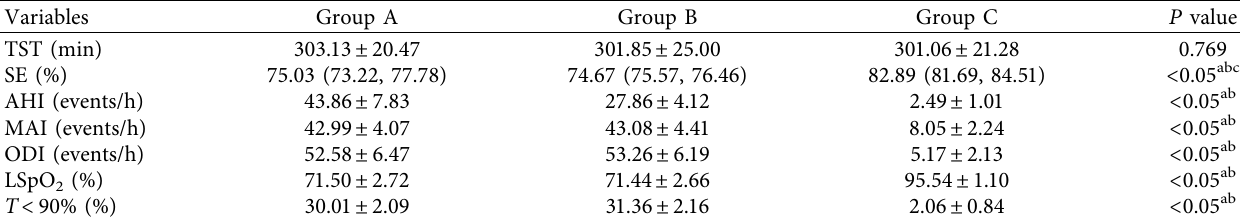
Table 3: Comparison of sleep study parameters between three groups.